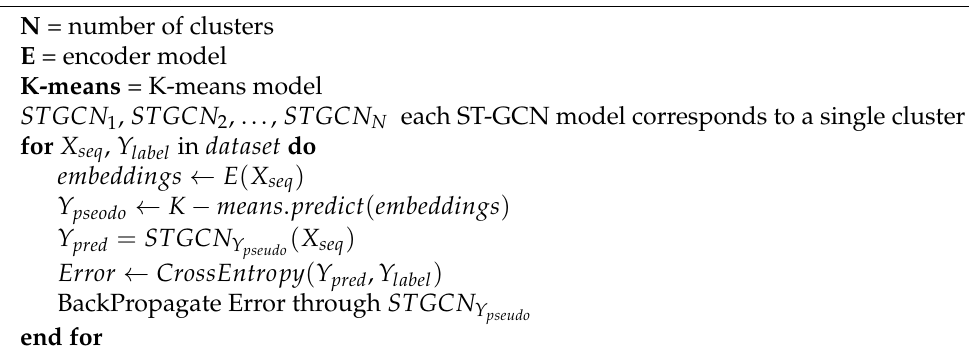
Algorithm 1 Algorithm for training the proposed architecture.